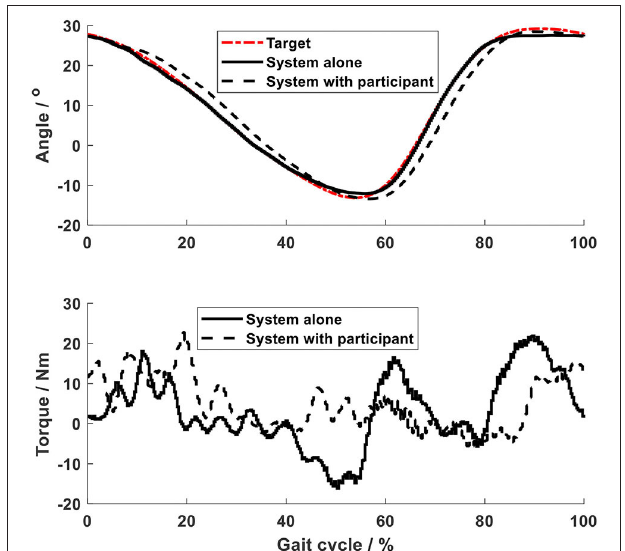
FIGURE 8 | Hip joint.